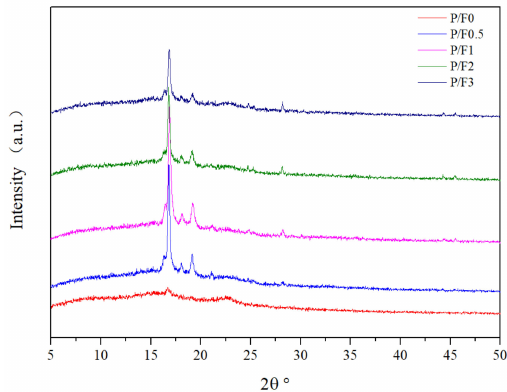
Figure 7. XRD patterns of P/F films annealed for 2 h at 110 ◦ C.